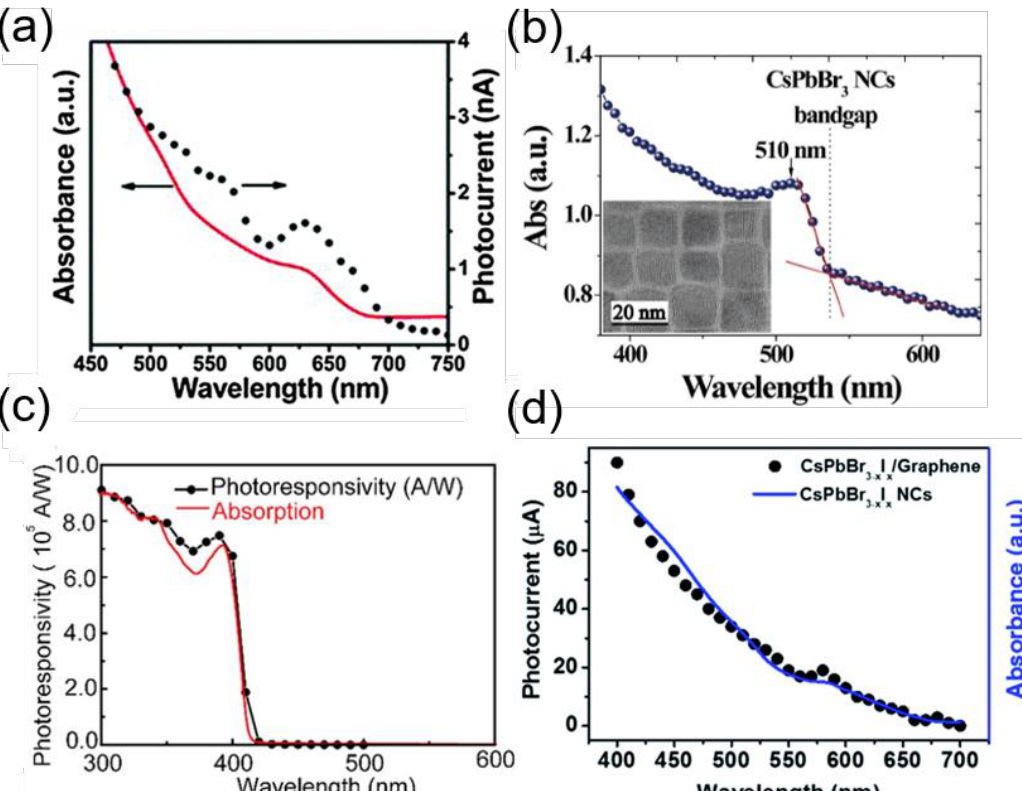
Figure 10. ( a ) Absorbance and photocurrent of CsPbI 3 NCs [6]. Copyright 2016 Royal Society of